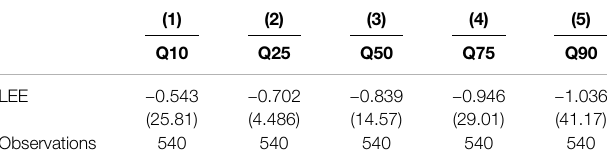
TABLE 9 | Panel quantile regression of LEE on CO 2 emissions.